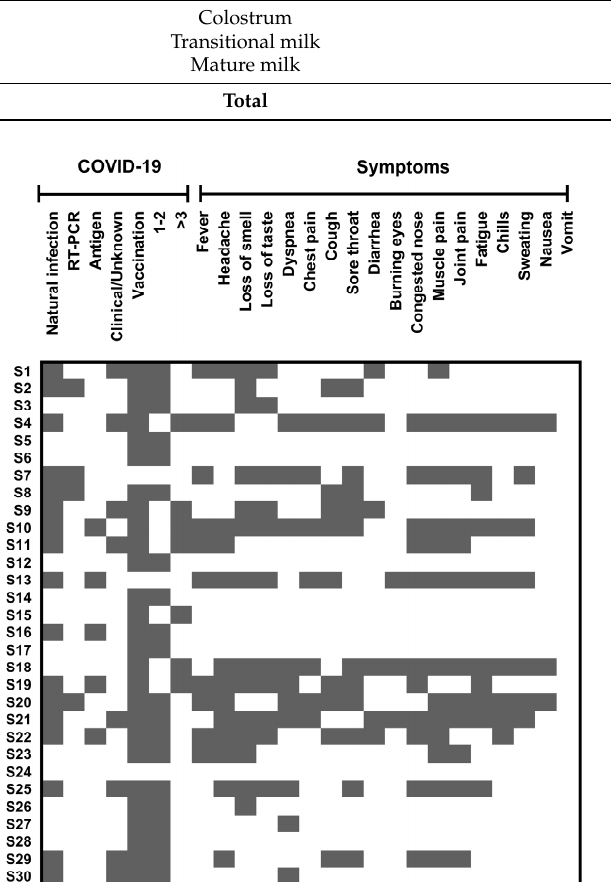
Figure 1. COVID-19 and related symptoms in the studied population. Heat map representing nat- ural infection, diagnostic (RT-PCR, antigen, clinical/unknown), vaccination, number of doses (1–2 or ≥ 3), and symptoms related to the infection. S: sample and 1–30: designed number for each partic- ipant. Grey parts indicate the presence of the analyzed variable.